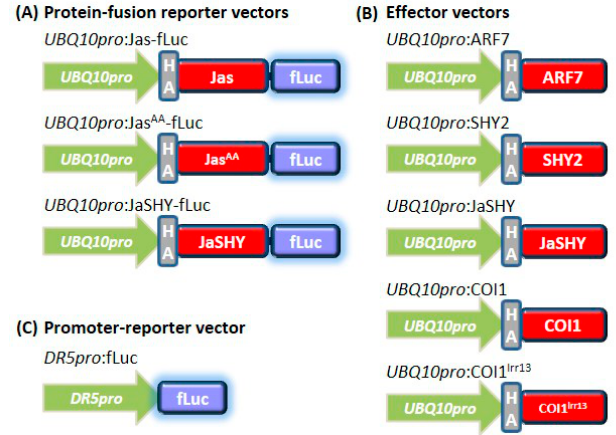
Figure 1. Scheme of vectors used for protoplast transient transfections in this study. ( A ) The protein-fusion reporter vectors. The coding sequences of wild-type and mutant Jas-motif and the JasSHY chimeric protein were fused in-frame to the N-terminus of firefly luciferase (fLuc) reporter gene. Expression of reporter proteins were under the control of the UBQ10 promoter. ( B ) The effector vectors. Expression of SHY2, JaSHY chimera, COI1 and COI1 mutant effector proteins were placed under the control of the UBQ10 promoter. All reporter and effector proteins contain a hemagglutinin (HA) epitope tag at the N-terminus. ( C ) The promoter-reporter vector. The auxin responsive DR5 promoter sequence was fused to the firefly luciferase (fLuc) reporter gene. Not drawn to scale.